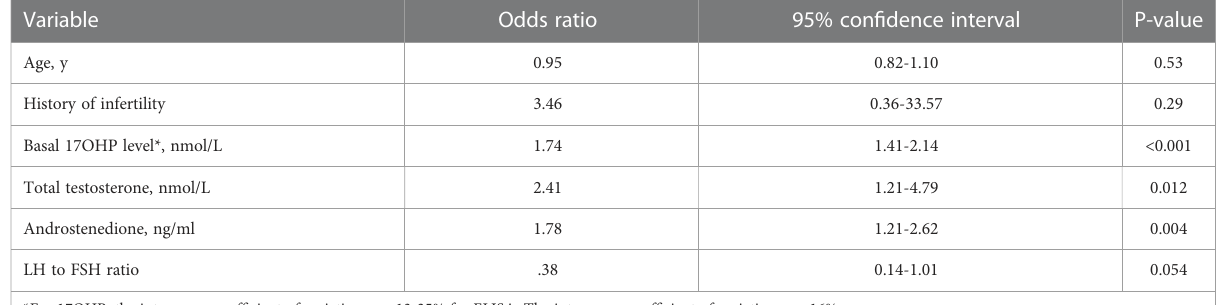
TABLE 6 Multivariate analysis for predictors of NCCAH among the ELISA